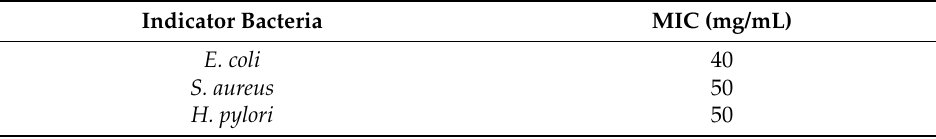
Table 3. MIC of EPS against indicator bacteria.